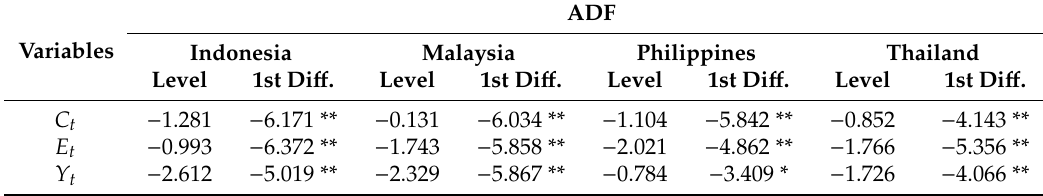
Table 3. Unit root results.